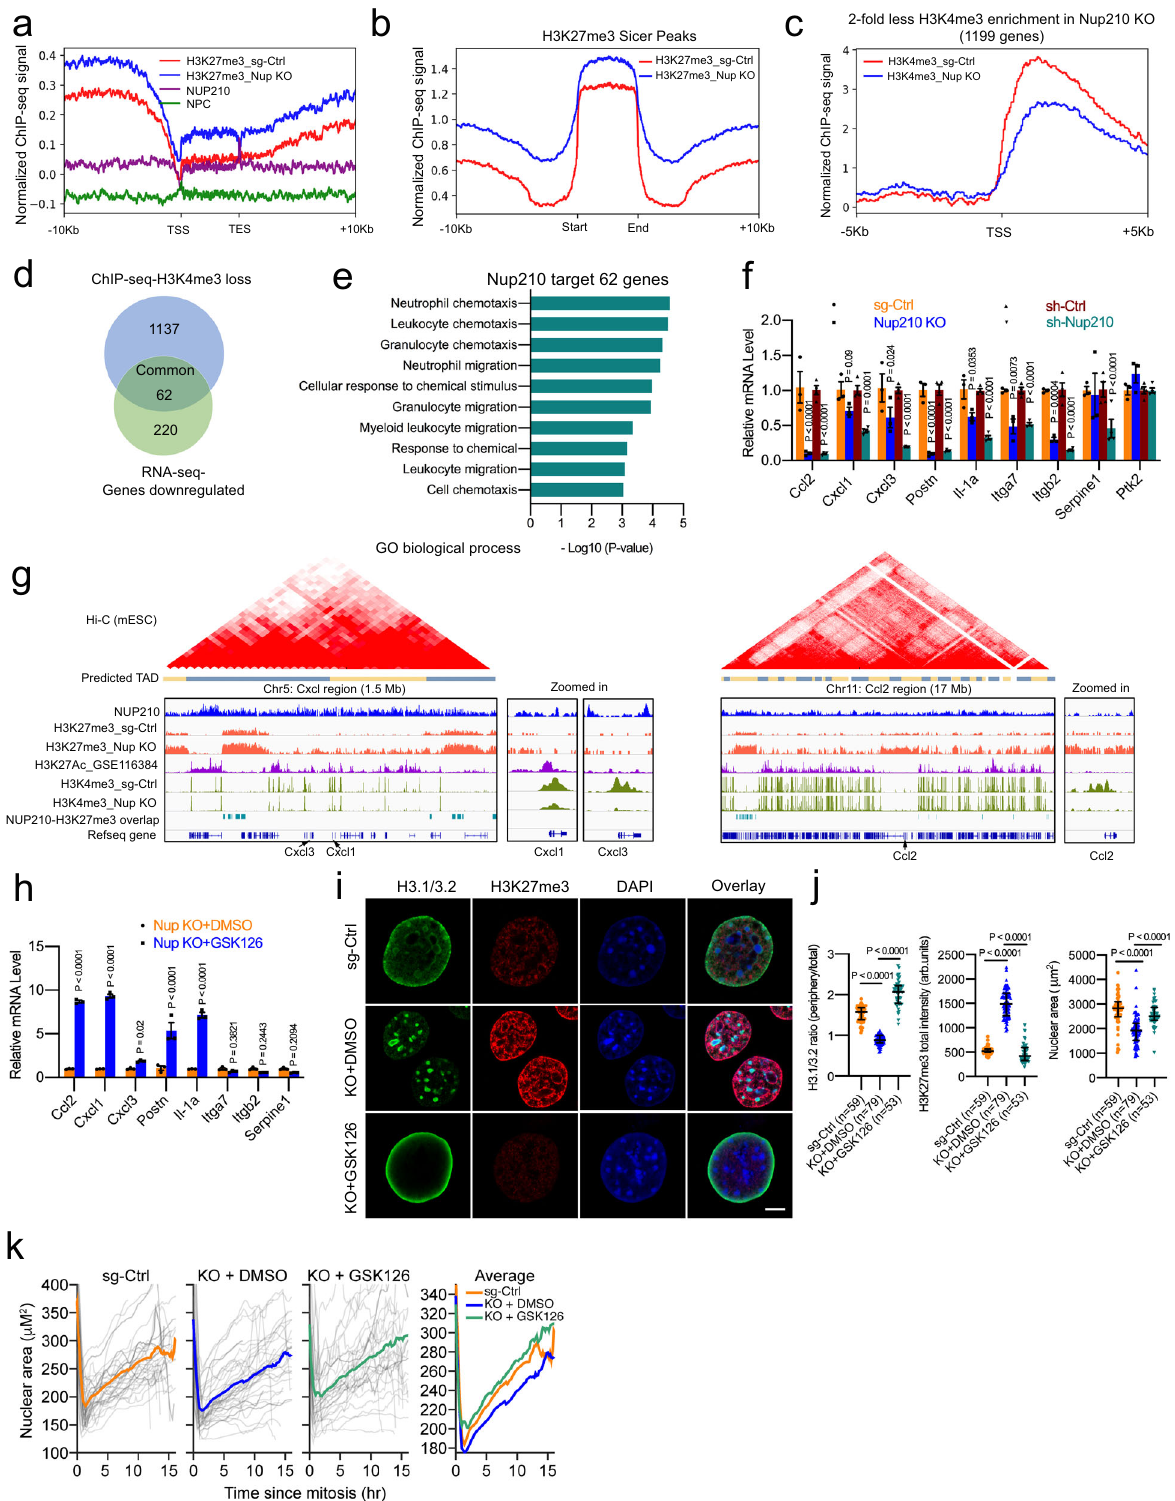
NUP210 is a LINC (linker of nucleoskeleton and cytoskeleton) complex-associated protein and regulates mechanosensitive gene expression . As mechanotransduction is mediated through the nuclear envelope-anchored LINC complex proteins 42,44 , we asked whether NUP210-dependent mechanical response is mediating through its association with LINC complex proteins. Co-IP revealed that NUP210 preferentially interacts with LINC